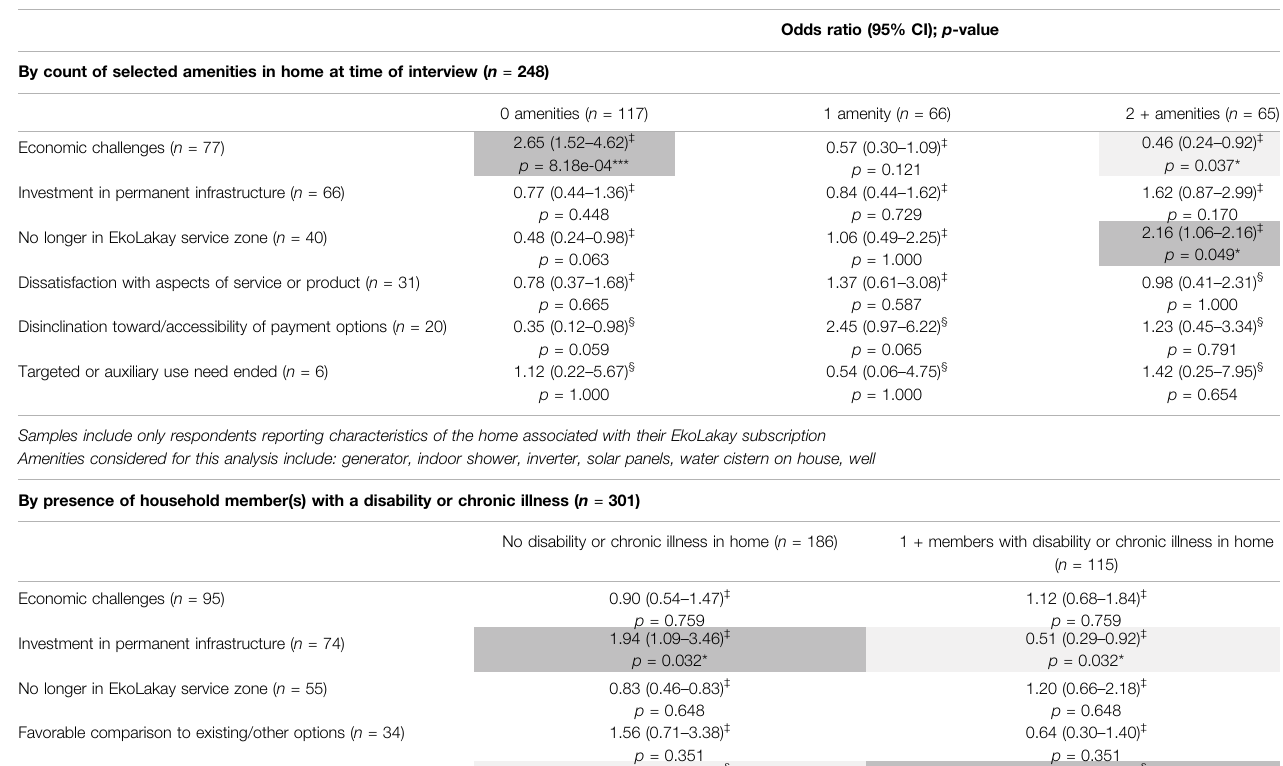
TABLE 4 | Reported factors affecting termination of EkoLakay subscription, by selected household characteristics.